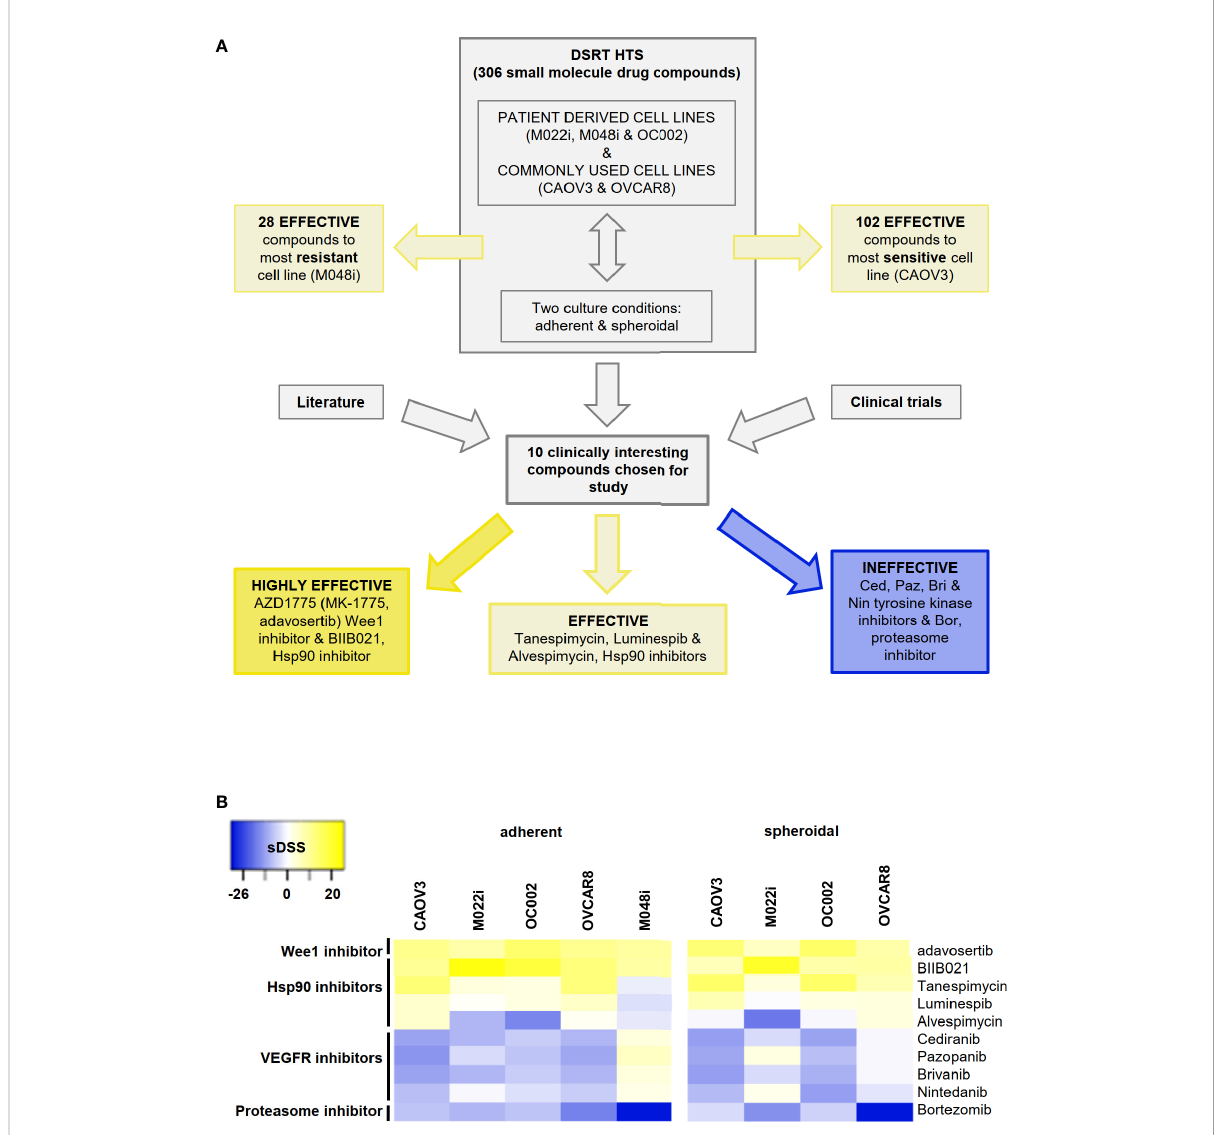
FIGURE 1 High-throughput drug sensitivity and resistance testing (DSRT) with 306 drug compounds. (A) Study design and basis for selection of small molecules for further analyses. DSRT was performed with fi ve HGSOC cell lines in adherent and spheroidal culture conditions. The number of effective compounds varied between 28 (M048i) and 102 (CAOV3). Based on literature search and ongoing clinical trials, 10 compounds were selected for further cytotoxicity tests, which divided compounds into three categories: highly effective, effective, and ineffective. (B) Heatmap of the selected drug compounds based on sDSS (selective drug sensitivity score) values tested in adherent and spheroidal conditions. Bright yellow = sensitive, dark blue = resistant; sDSS >5 effective, sDSS ≥ 10 highly effective. M048i spheroidal data not